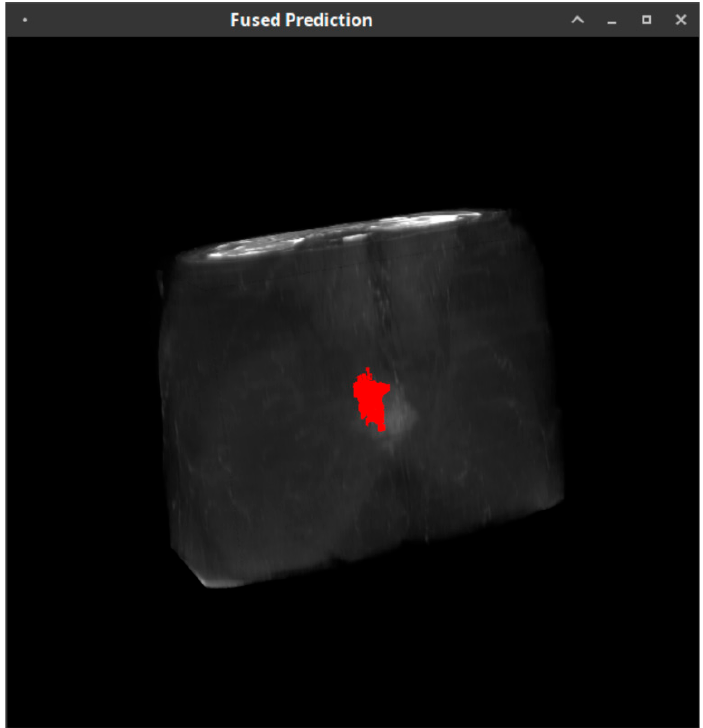
Figure 3. Classification results from the pipeline for the same patient in Figure 2. On average, the classification processing pipeline required about 10 min for feature extraction and classification of each patient (depending on the processed datasets). All tests were performed on a common reference system (Intel Core i7-1165G7at 3.5GHz, 40GB of RAM, running on Debian 11 GNU/Linux).